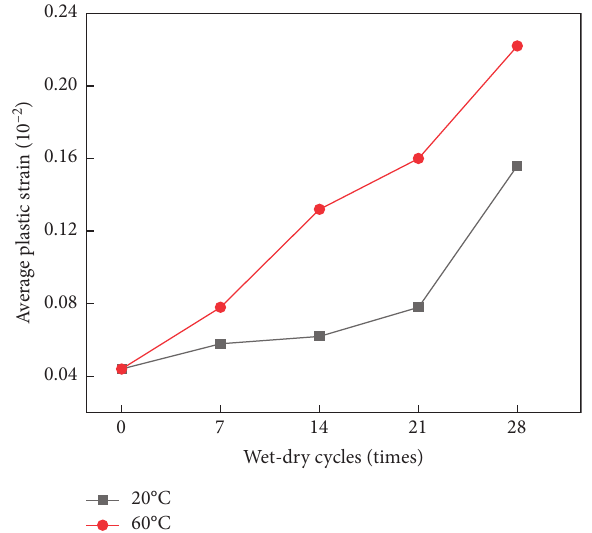
Figure 7: Average plastic strain in 10th–60th loading cycle under different wet-dry cycles.